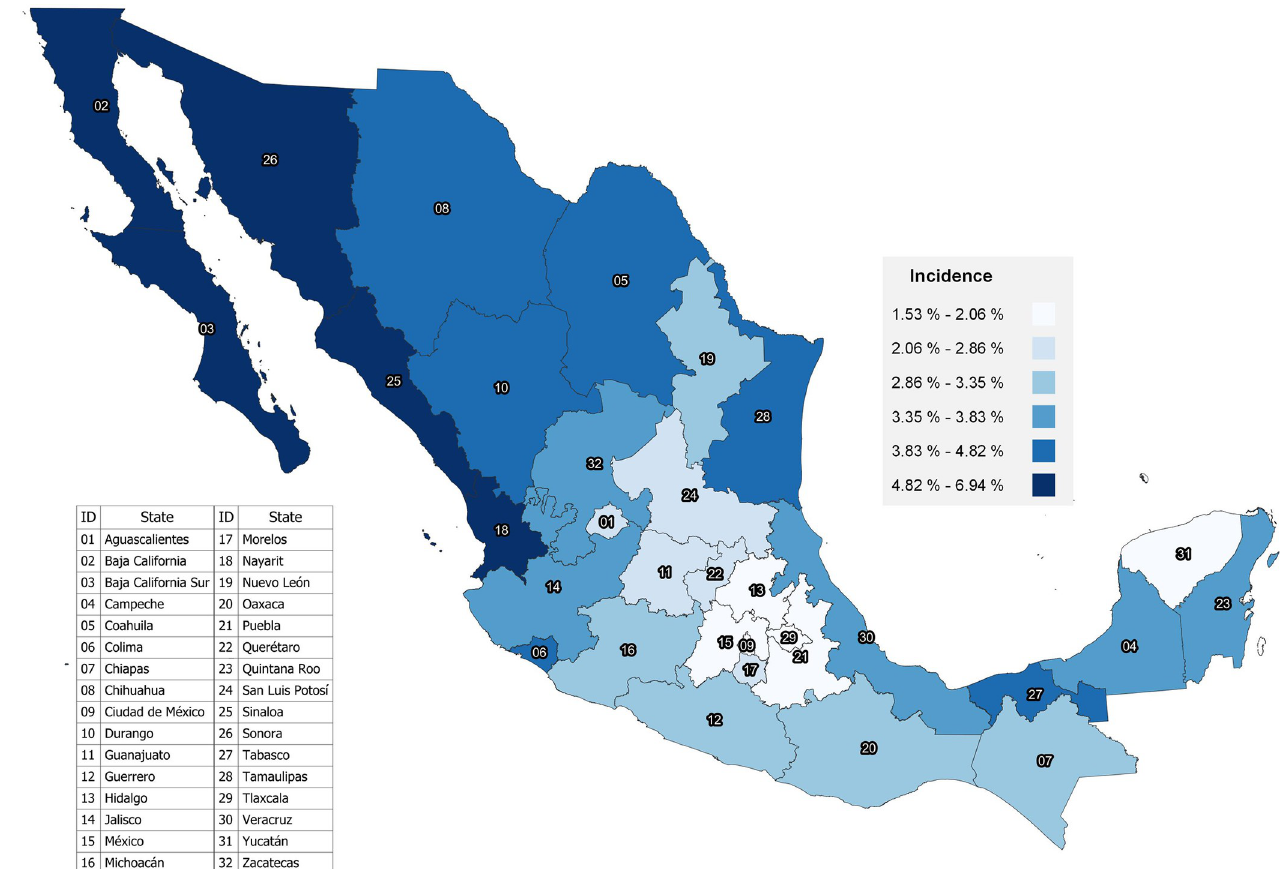
Fig 1. FM incidence in live births in Mexico at the state level in males,